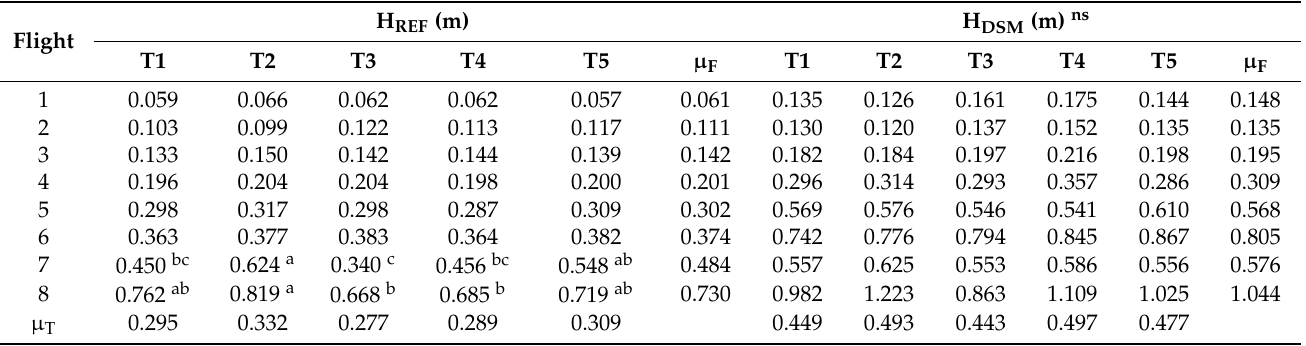
Table 4. Mean values of H DSM and H REF according to flight inspection and